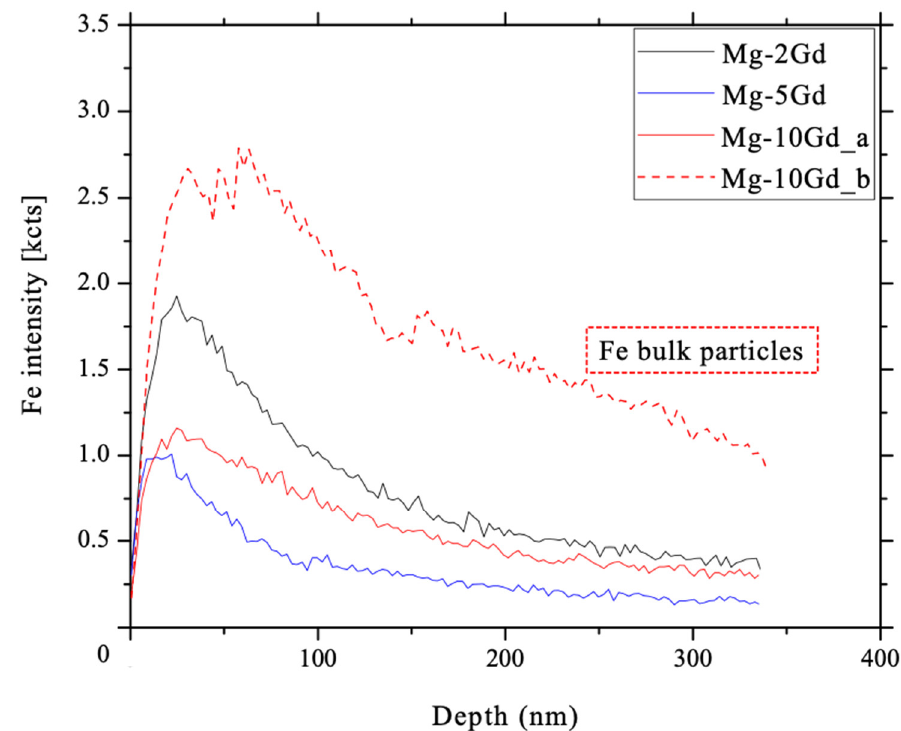
Figure 10. Depth profiles for Fe in the sub-surface of as-received Mg- x Gd alloys. The Fe intensity decreases at a depth around 30 nm. One profile of each alloy (Mg-2Gd, Mg-5Gd, Mg-10Gd_a) is plotted and show the decrease of Fe intensity to be virtually zero for the case of Fe surface contamination. The decrease of Mg-10Gd_b is not virtually zero after around 340 nm, due to additional bigger Fe particles inside the bulk.